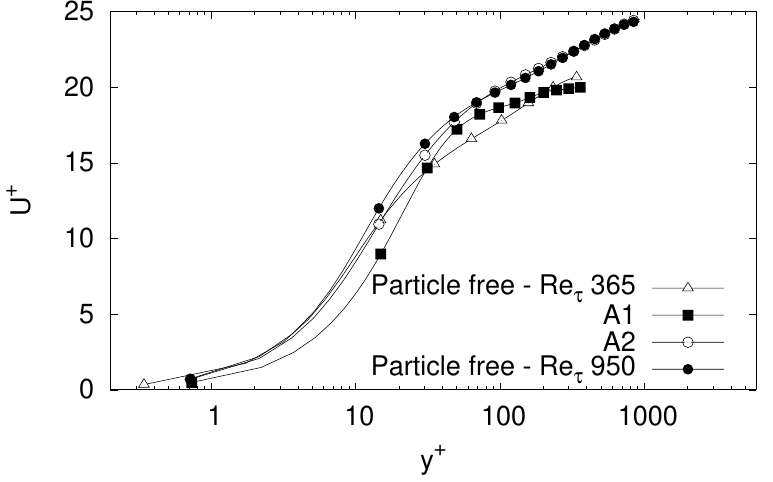
Figure 7. Mean velocity profiles for A1, A2 and particles free cases. ( A 1 : u τ = 0.073; A2: u τ = 0.188). φ m = 2.96, τ p ≈